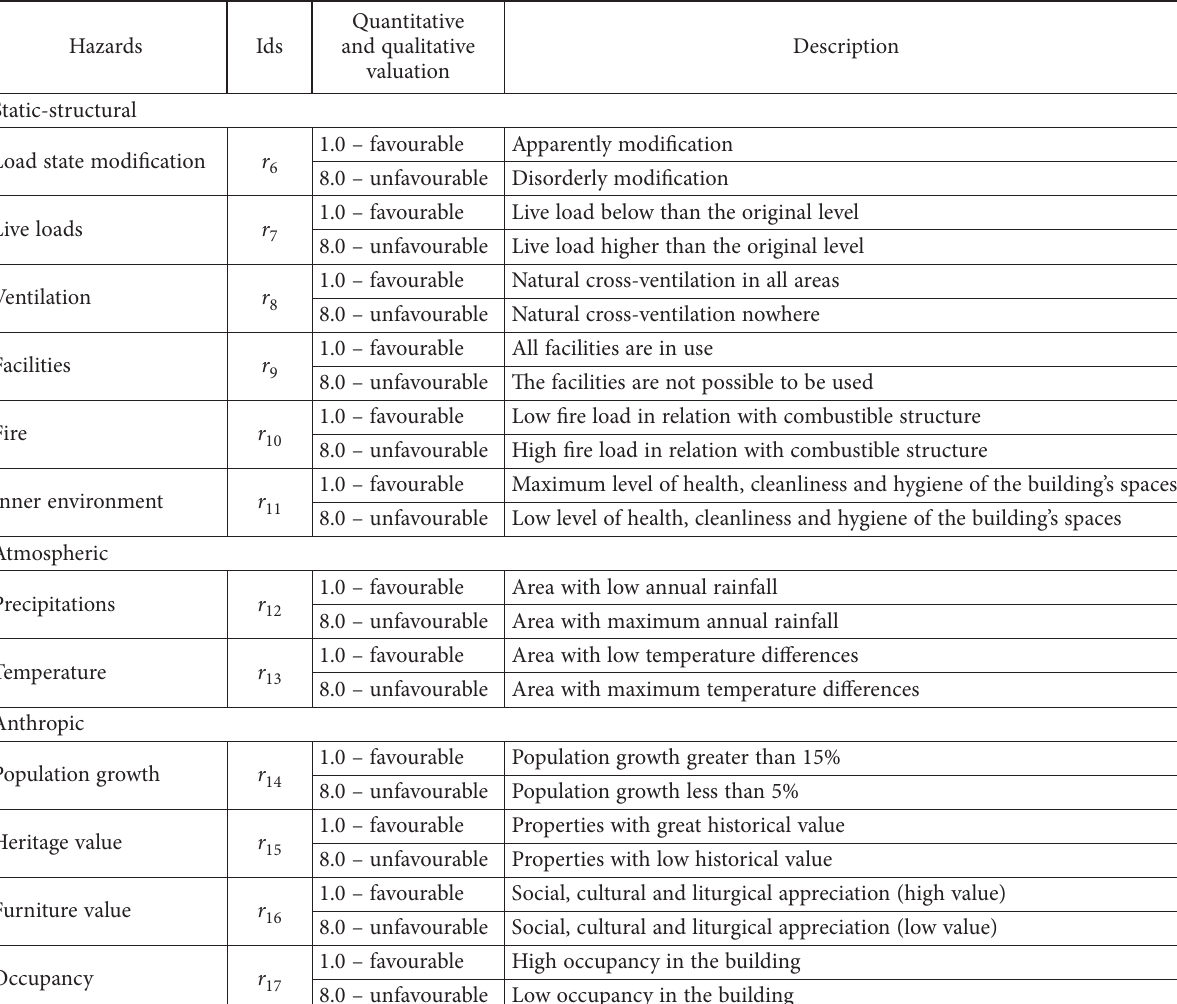
Table 2. External hazards input variables’ valuation description on fuzzy model ( FBSL 2.0